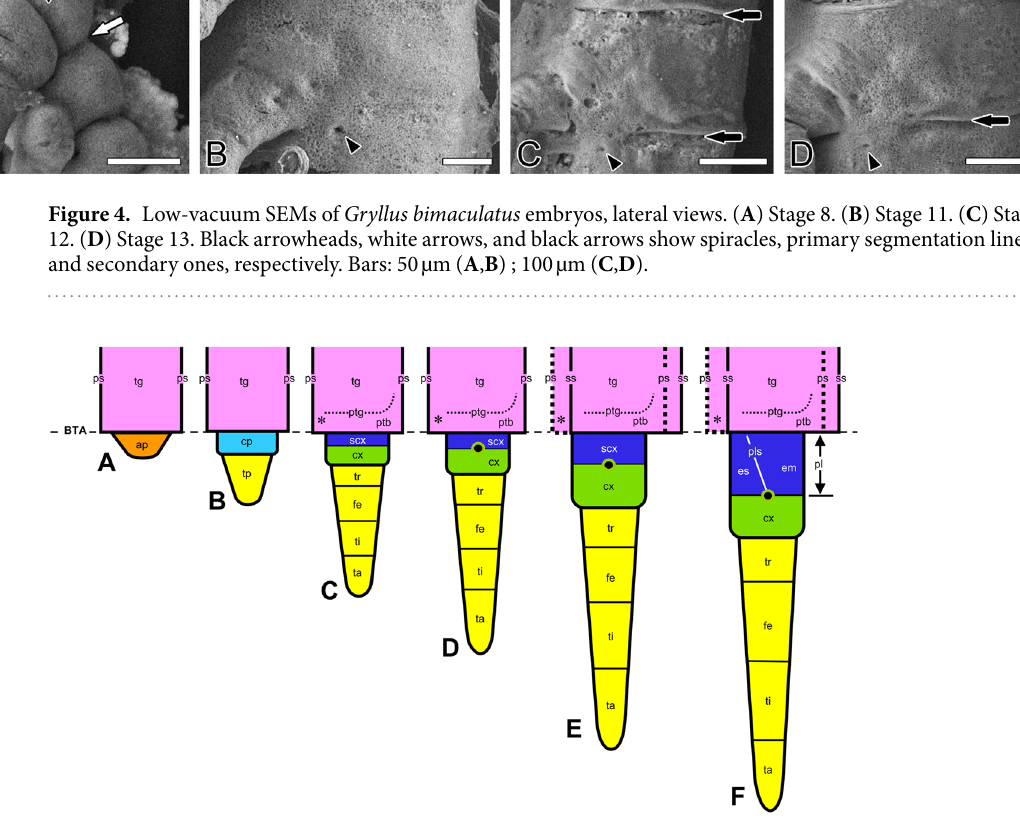
Figure 5. Diagrammatic summary of the morphogenesis of thoracic segments in Gryllus bimaculatus . ( A ) Stage 6, lateral bulge is divided by the boundary between the tergum and appendage (BTA) into the proximal tergum (tg: pink) and distal appendage (ap: orange). ( B ) Stage 7, the appendage is divided into the proximal coxopodite (cp: light blue) and distal telopodite (tp: yellow). ( C ) Stage 9, the telopodite is subdivided into the trochanter (tr), femur (fe), tibia (ti), and tarsus (ta). The coxopodite is subdivided into the proximal subcoxa (scx: dark blue) and distal coxa (cx: green). A spiracle (asterisk) appears at the anteroventral region of the tergum, and then the paratergal groove (ptg) and the paratergal bulge (ptb) appear. ( D ) Stage 11, the pleuro-coxal joint (black circle) forms in the boundary of the subcoxa and coxa. ( E ) Stage 12, the boundary of segments